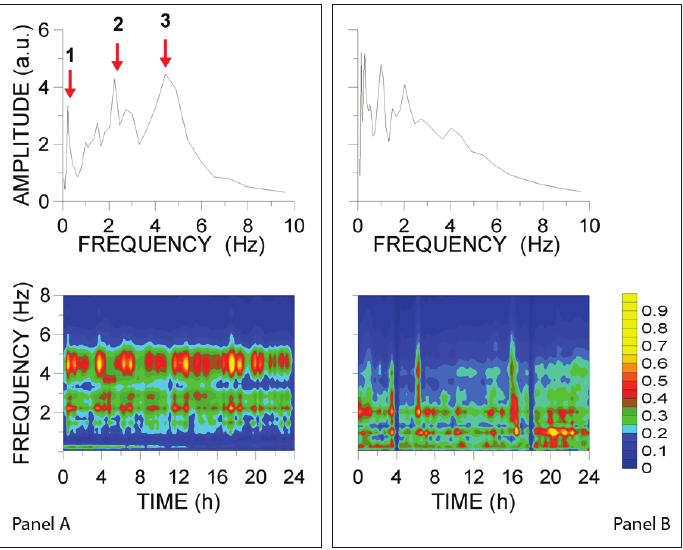
Fig. 3. Daily average spectra ( top ), expressed in arbitrary units (a.u.), and spectrograms ( bottom ) of seismic signals (STR1, vertical component) computed on a 15-min sliding window. Panel A shows the typical Strombo- lian activity (February 16, 2007). Spectral peak 1 corresponds to the VLP component; peak 2 is associated with the volcanic tremor; peak 3 represents the explosion-quakes. Panel B shows the seismic activity after the begin- ning of the effusive phase (February 28, 2007). Note that the distribution of the spectral amplitude changes; in particular, peak 3 is not